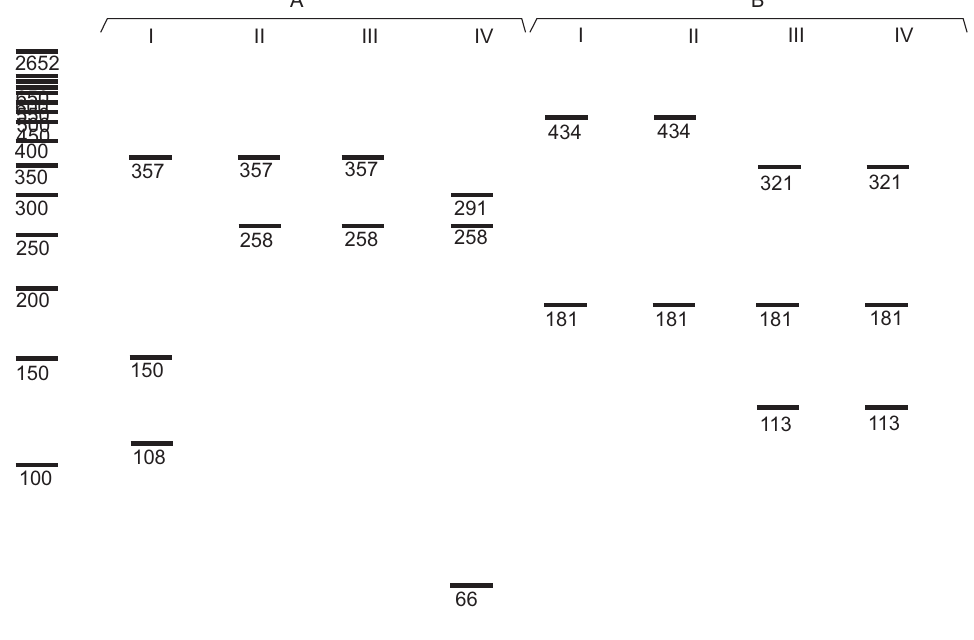
Figure 2. Virtual gel electrophoresis of Cytochrome b RFLP profiles for the four manatee species under consideration. The Cytochrome b fragment is digested with HpyCH4III (A) which yields a distinct RFLP profile of 357+150+108bp ( T. inunguis ) (I) ; 357+258bp ( T. manatus and T. senegalensis ) (II and III) ; 291+258+66 ( D. dugon ) (IV). Digestion with MwoI (B) yields distinct RFLP profiles of 434+181bp ( T. inunguis and D. dugon ) (I and II), and 321+181+113bp ( T. manatus and T. senegalensis ) (III and